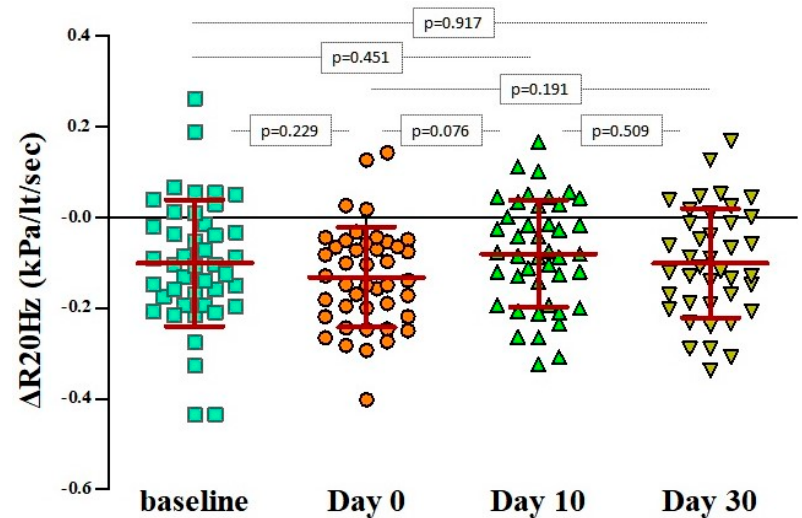
Figure 4. Pairwise comparisons of ∆ R20Hz values at baseline, on day 0 (beginning of the wheezing episode), and 10 and 30 days after. The bars and in-between lines represent the mean and SD. All pairwise comparisons are presented with p -values that have been estimated with paired Student’s t-test. Pulmonary resistance (R) at 20 Hz (R20); ∆ R20Hz = (R20Hz post-bronchodilation – R20Hz pre-bronchodilation ) / R20Hz pre-bronchodilation.